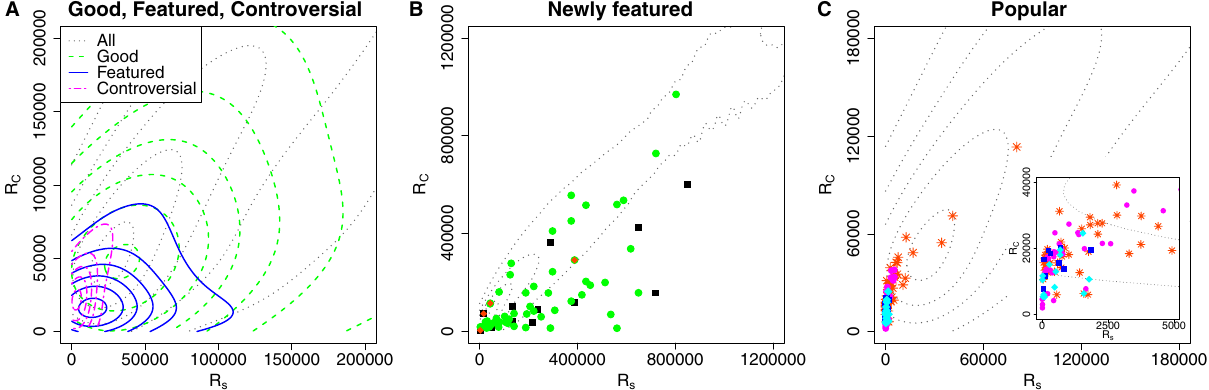
Figure 3. Distributions of labeled Wikipedia articles in the strength rank vs. complexity rank plane. ( A ) Contour plot of the density distributions of all (gray dotted line), “good” (green dashed line), “featured” (blue solid line), and “controversial” (magenta dot-dashed line) articles. In comparison to the density distribution of all as well as “good” articles, the “featured” and “controversial” articles are accumulated in the region of higher ranks, i.e. where both R s and R C are small, while the “good” articles have lower ranks and both R s and R C larger. The “featured” articles tend to have higher complexity rank than all articles for its strength, while “controversial” articles tend to have extremely high strength rank but smaller complexity rank than “featured” articles. ( B ) In the R s vs. R C plane the positions of “newly featured” articles that were labelled “featured” within the period from 20th September 2019 to 20th February 2020. Green circles and black squares are the “newly featured” articles promoted from the “good” articles and non-labeled articles, respectively, shown on top the contour (gray dotted) lines of the density distribution of all articles. The “newly featured” articles are mainly promoted from the “good” articles, the distribution of which is concentrated in the lower triangle of the R s vs. R C plane compared to the distribution of all articles. The original positions of “newly featured” articles are found further to the right, compared to the overall distribution of “good” articles, which indicates a strong tendency that articles with higher complexity rank relative to strength rank correlate with the higher chance for them to obtain “featured” label. This tendency is stronger for the originally non-labeled articles. The “newly featured” articles that are also labelled as “emerging popular” articles (red diamonds), having earned top 5, 000 page views around the observation period, tend to be located in the upper triangle region, i.e. the strength rank is higher than the complexity rank. ( C ) In the R s vs. R C plane the positions of articles labelled “popular” (orange star), “popular” & “featured” (blue squares), “popular” & “controversial” (magenta circles), and “popular” & “featured” & “controversial” (cyan diamonds), shown on top of the contour (gray dotted) lines of the density distribution of all articles. These “popular” singly, doubly and triply labelled articles are localized in the region of high strength rank and relatively high complexity rank, such that “popular” & “controversial” labelled articles correlate with higher strength rank while “popular” & “featured” labelled articles correlated with the higher complexity